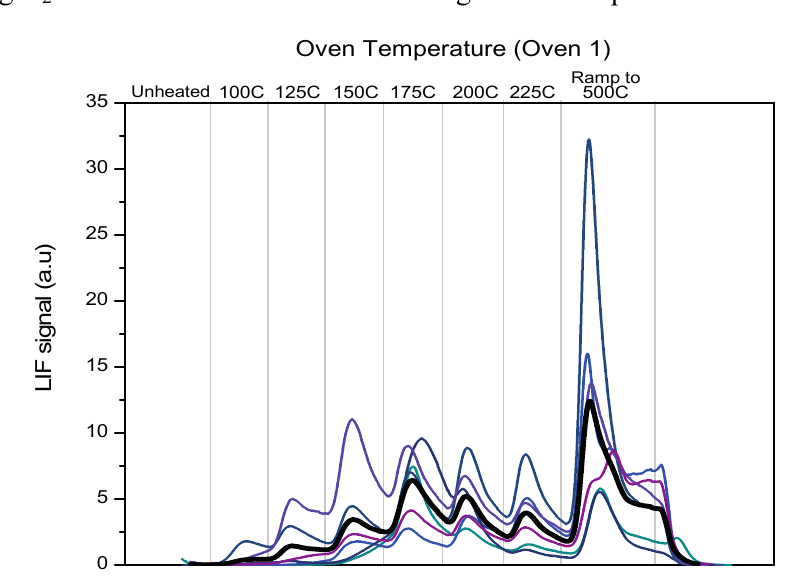
. Denuders were loaded by flowing N 2